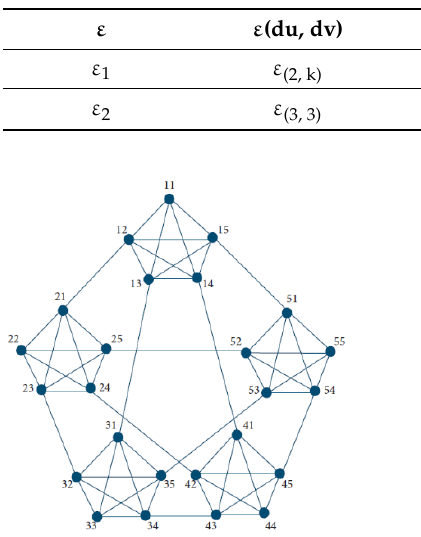
Figure 13. Sierpinski Network S ( n , k) .